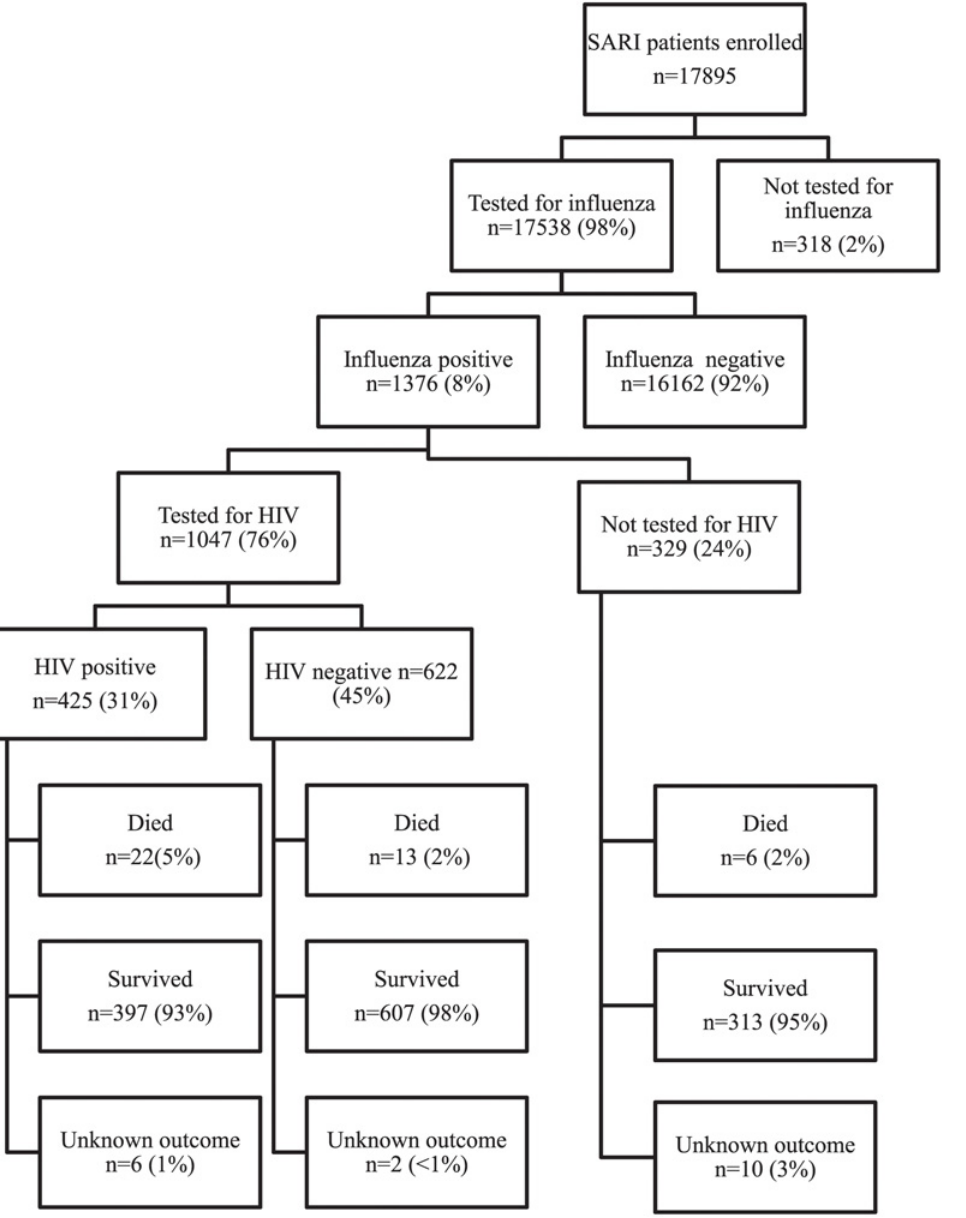
Fig 1. Flow chart of patients enrolled in the South African severe acute respiratory illness surveillance programme at four sites in South Africa, 2009 – 2013. HIV — human immunodeficiency